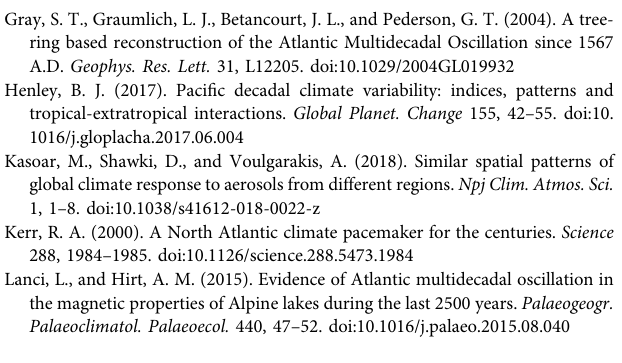
Frontiers in Earth Science |